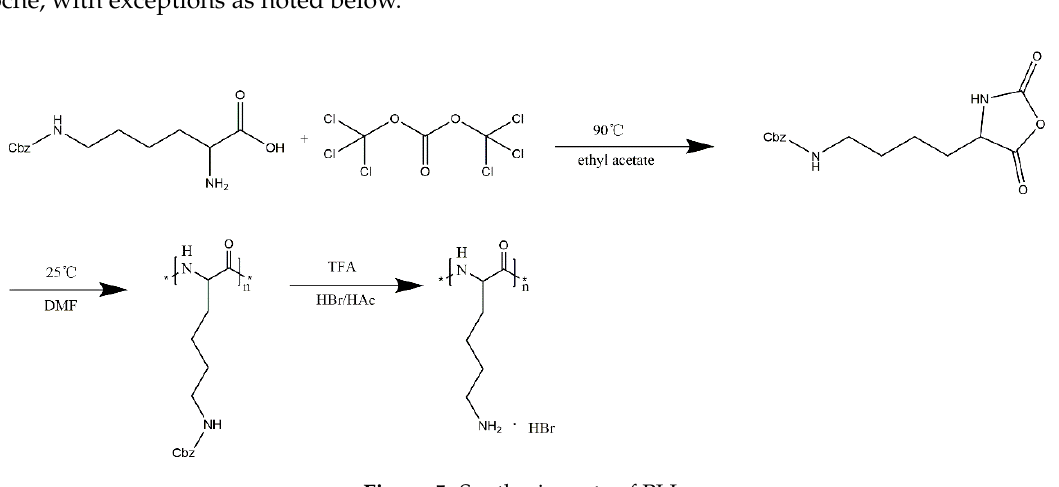
Figure 5. Synthesis route of PLL.